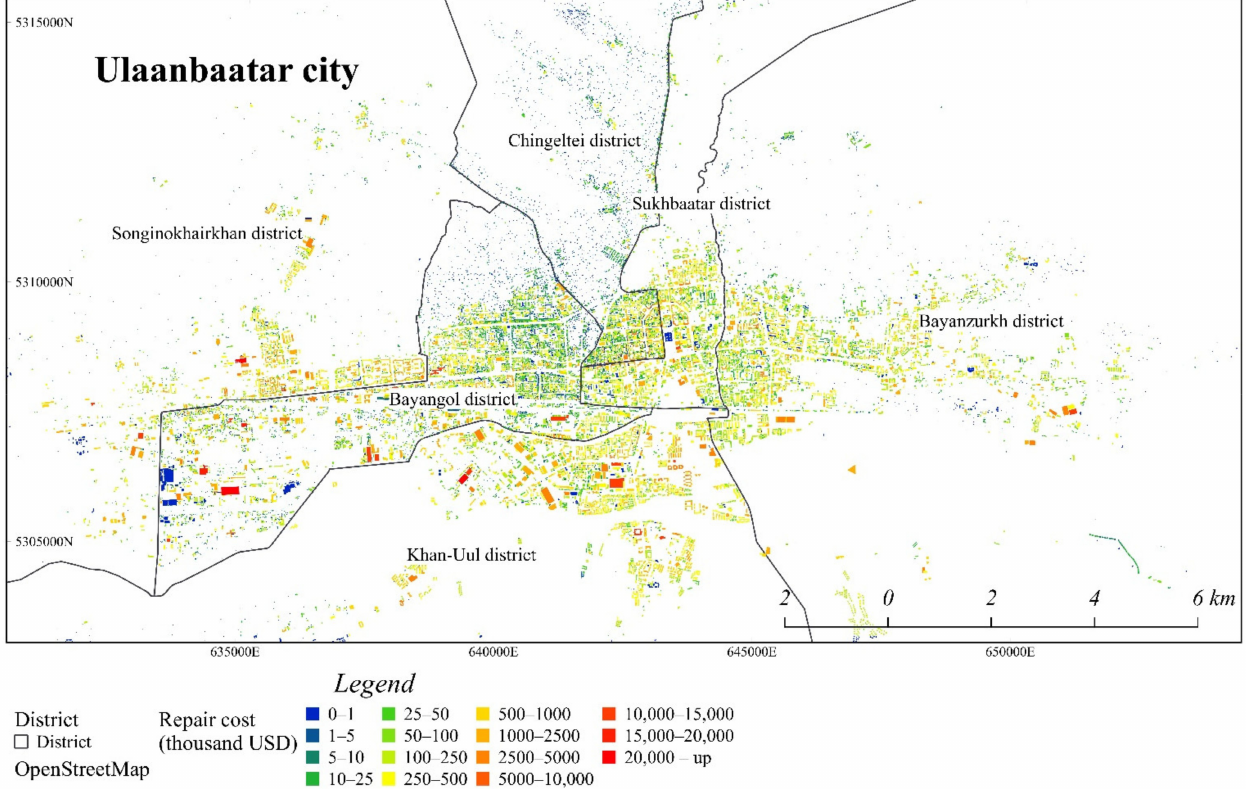
Figure 15. Distribution of MDR (mean damage ratio) estimated by vulnerability assessment in UB.